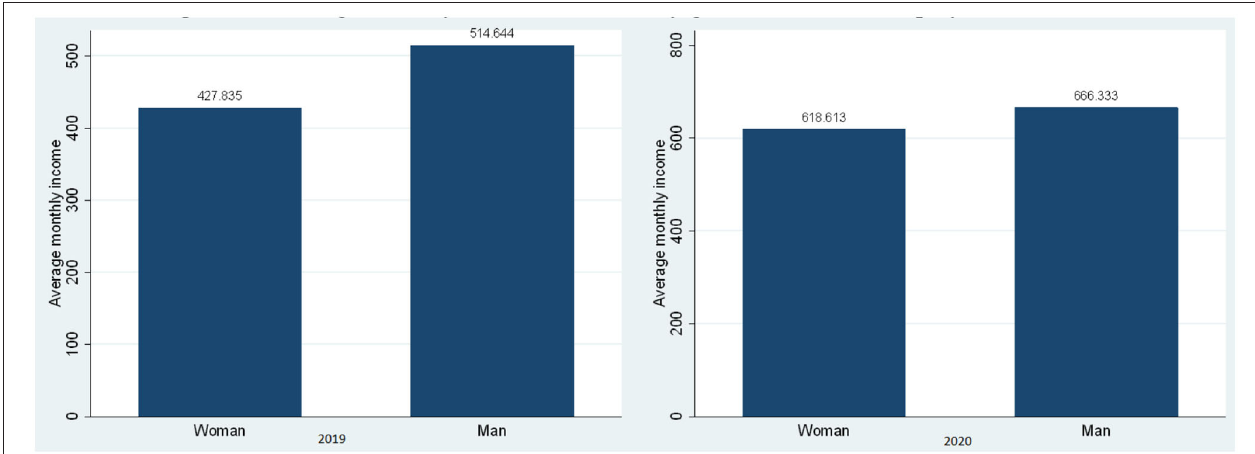
FIGURE 1 | Average monthly economic income by gender of the self-employed, 2019–2020. Source: Own elaboration with information from ENAHO-INEI-2019 and 2020.